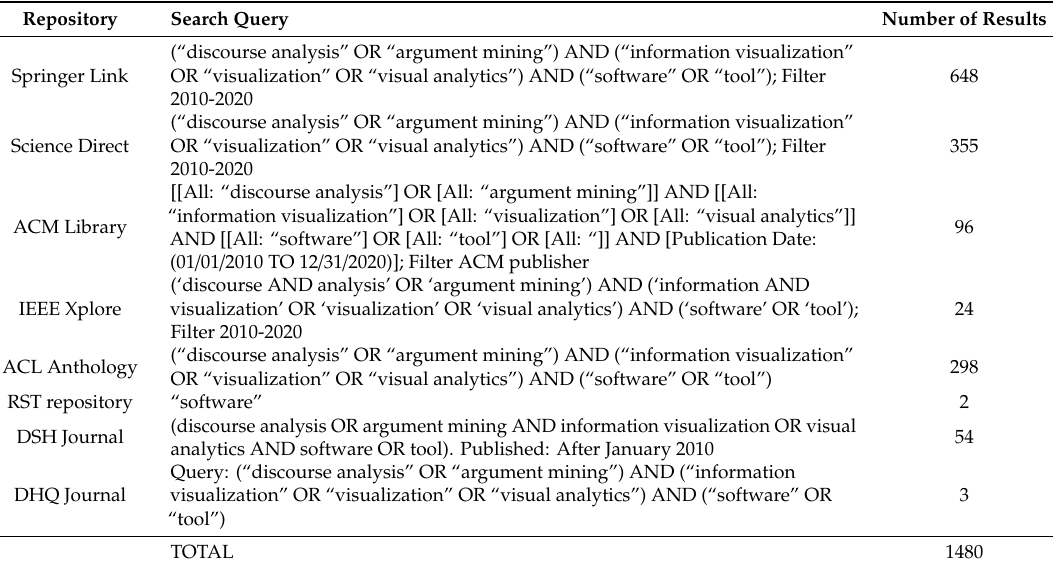
Table 1. SLR repositories, search queries and the number of resultant